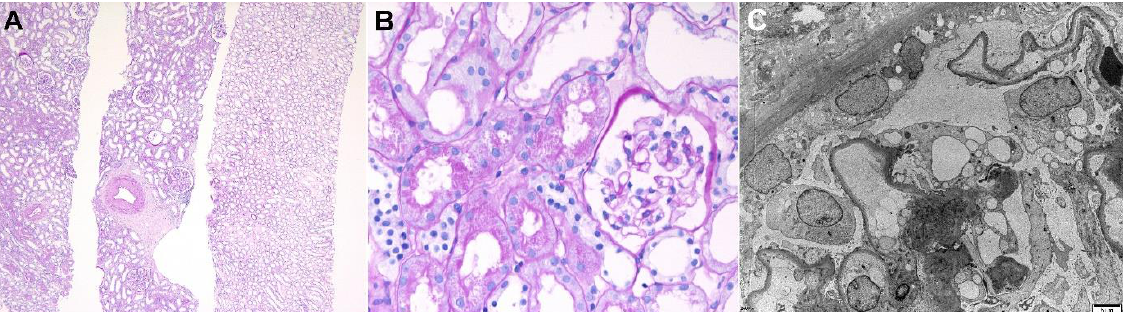
Figure 2. Pathologic findings of minimal change disease. Light microscopy: ( A ) In low magnification, no tubular atrophy or interstitial fibrosis was present (hematoxylin and eosin, ×40). ( B ) The picture shows a normally appearing glomerulus with protein reabsorption granules in tubules (hematoxylin and eosin, ×400). Electron microscopy: ( C ) Diffuse podocyte foot process effacement with microvillous transformation without electron-dense deposits were observed. The thickness of glomerular basememt membrane was normal (×2500, 80 kv).